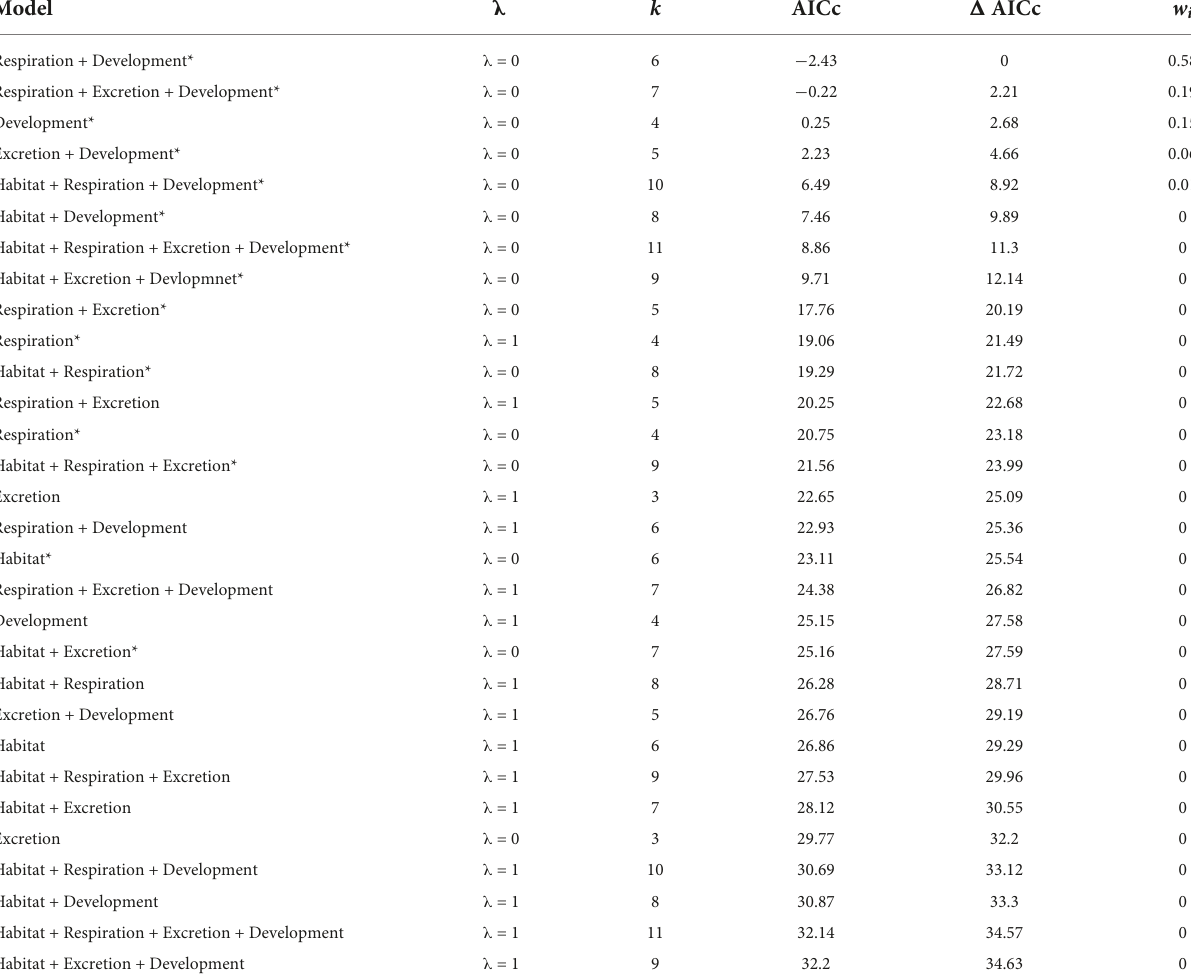
TABLE 4 Results for the subset (species belonging to the infraorders Anomura, Astacidea, and Brachyura) for phylogenetic generalized least-squares (PGLSs) models to explain variation in genome size as a function of habitat, respiration, excretion, developmental mode and their combinations.